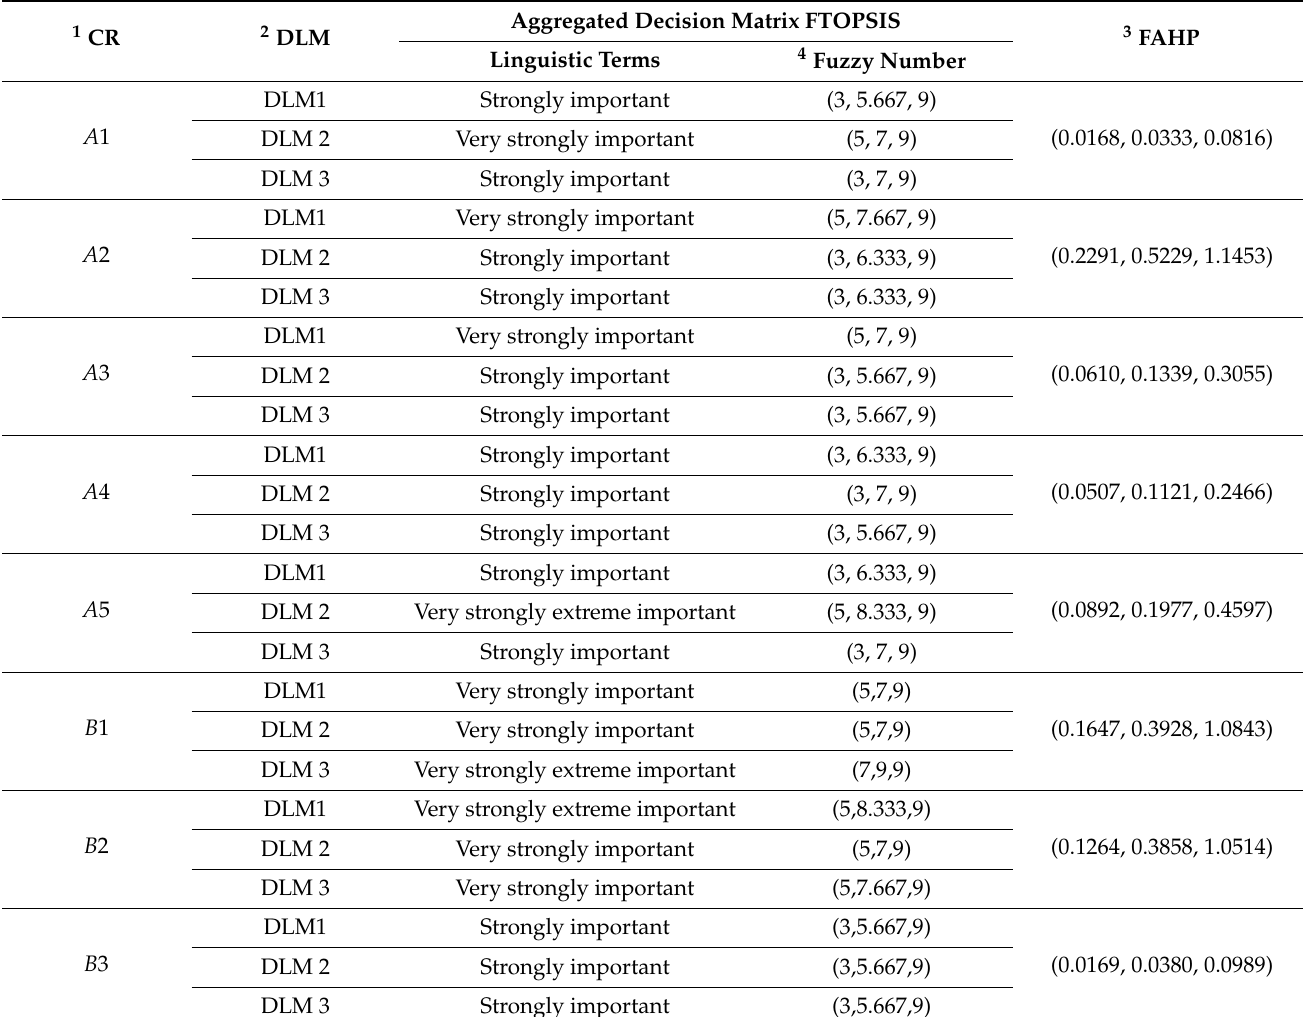
Table A2. The aggregated importance of weight for each criterion given by experts’ groups for each distance learning